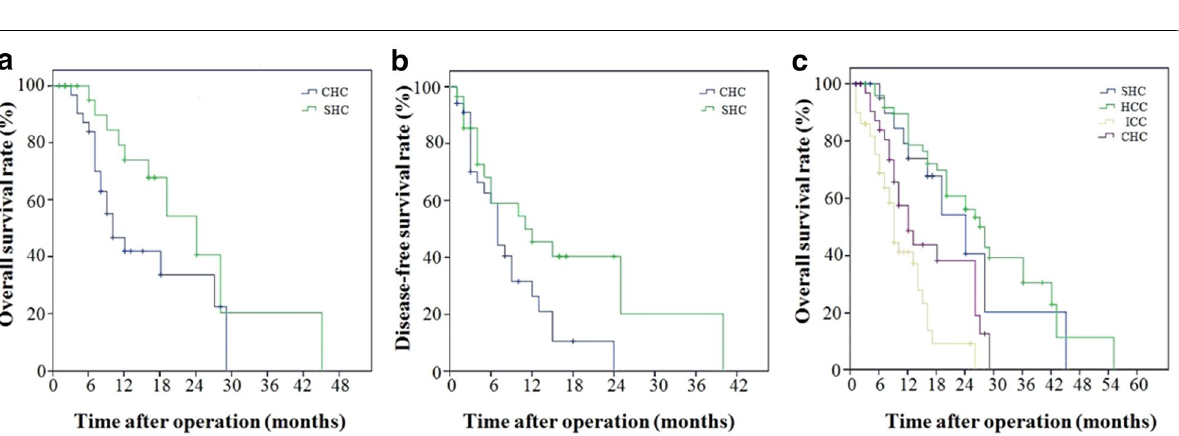
Fig. 3 Comparison of cumulative overall and disease‑free survival among patients with CHC, SHC, pure HCC, and pure ICC. a Cumulative overall survival curves of patients with CHC ( n c Cumulative overall survival curves of patients with CHC ( n